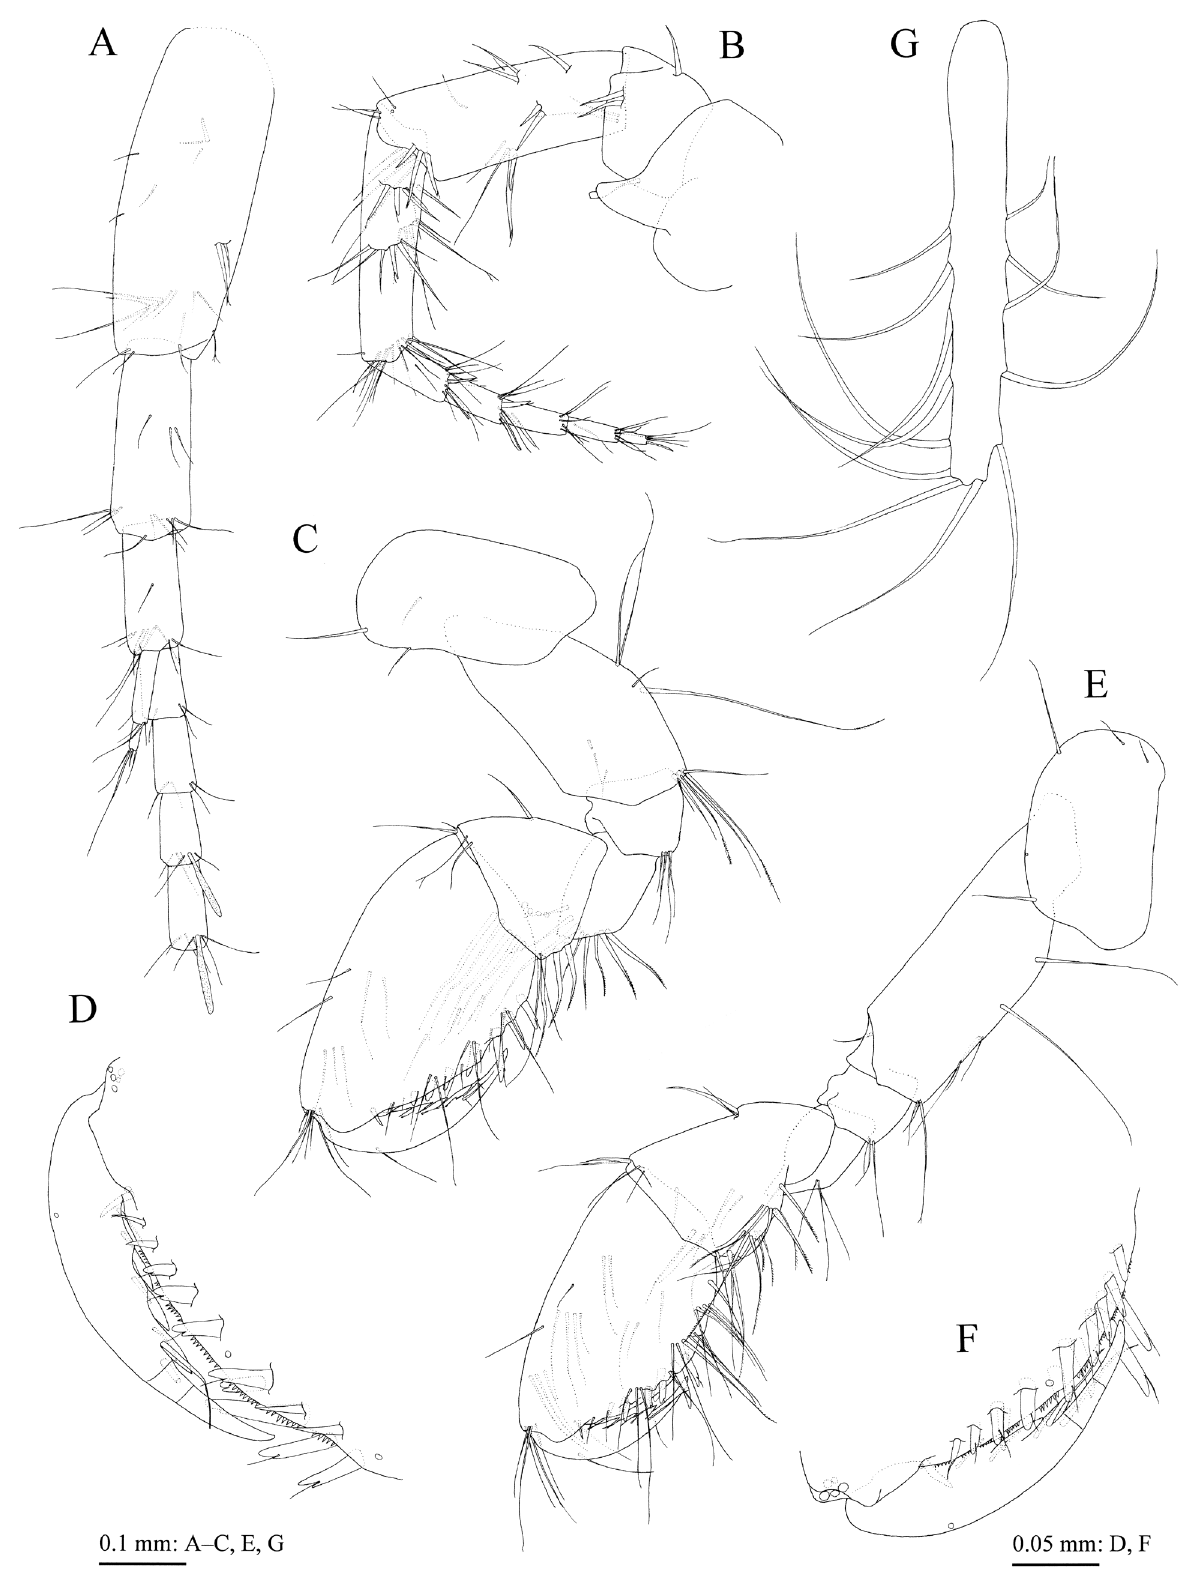
Figure 8. Pseudocrangonyx gudariensis Tomikawa & Sato, sp. n., paratype, female (3.1 mm), NSMT-Cr 24604. A antenna 1, medial view; B antenna 2, medial view; C gnathopod 1, lateral view; D palmar margin of propodus and dactylus of gnathopod 1, medial view; E gnathopod 2, lateral view; F palmar margin of propodus and dactylus of gnathopod 2, medial